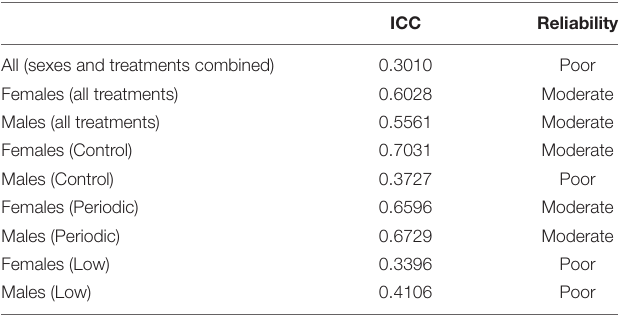
TABLE 3 | Intra-class coefficient (ICC) calculations for repeated capture and restraint of zebra finches.